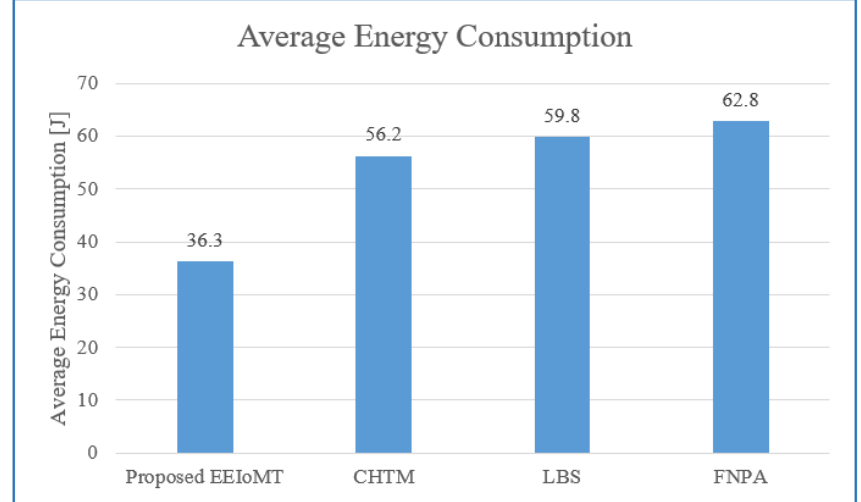
Figure 4. Comparison of Average Latency.